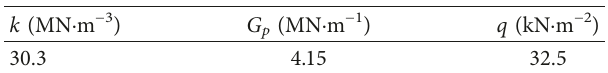
Figure 3: Tangential stress of the pipeline induced by internal pressure. Table 1: Calculation